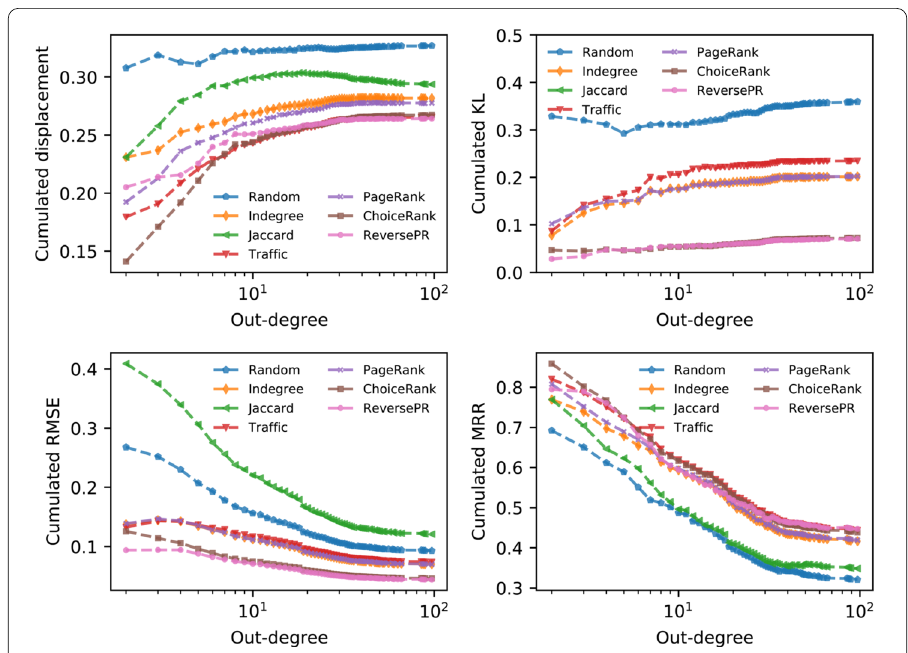
Figure 10 Cumulated evaluation metrics for the Citibike bike sharing network. Scores are reported as a function of the outdegree of the